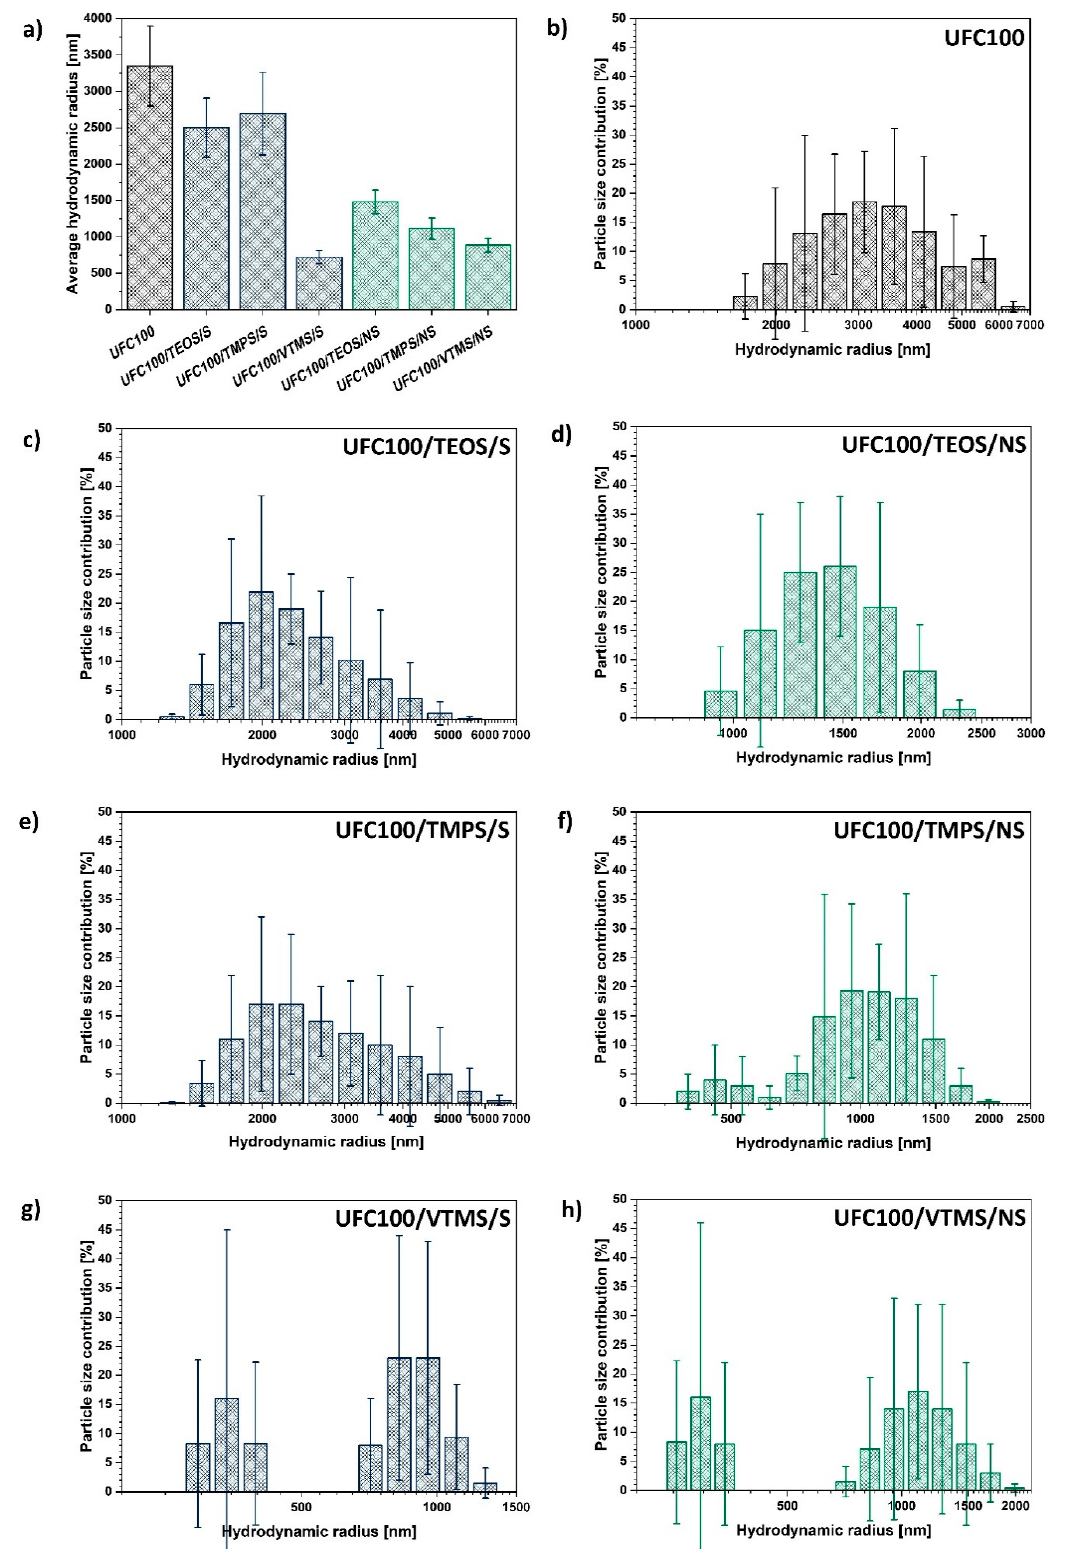
Figure 4. Dynamic light scattering analysis results of: ( a ) average hydrodynamic radii of analysed cellulose particles; ( b – h ) certain particle size distribution for different specimens.